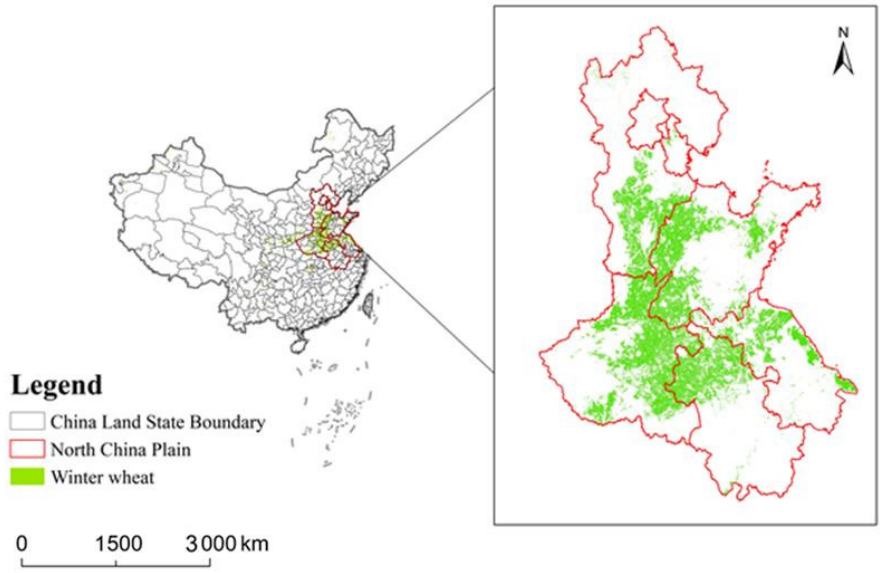
Figure 1. Winter wheat growing area in China.